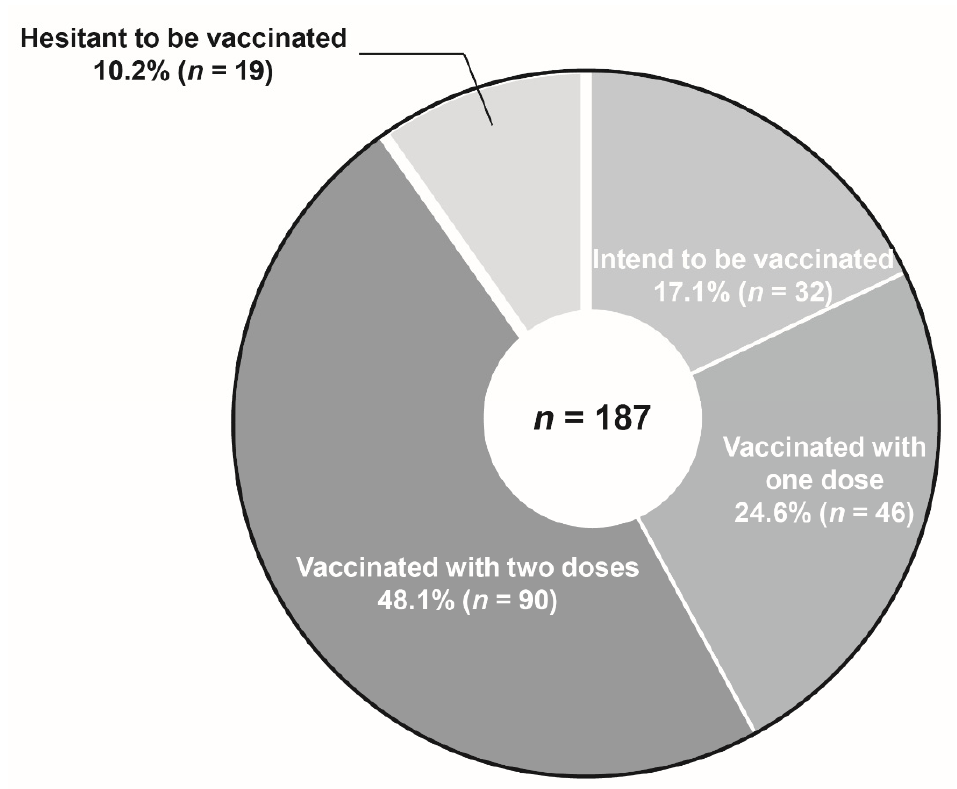
Figure 1. Willingness and hesitancy of patients with inflammatory bowel disease to receive a coronavirus disease 2019 vaccine.